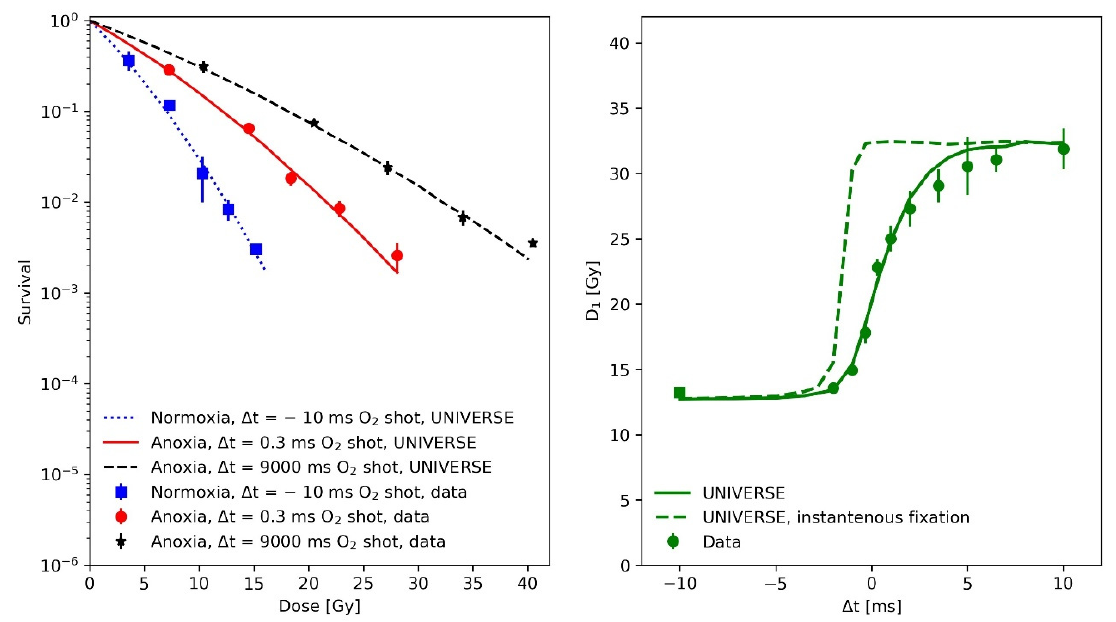
Figure 1. ( Left panel ): Measured (filled circles) and predicted (lines) V79 379A cell survival after a 5 ns electron pulse under various conditions and of O 2 contact times: squares and dotted line, normoxic condition with O 2 -shot contact 10 ms before electron pulse; stars and dashed line, anoxic condition with O 2 -shot contact 9000 ms after electron pulse; and circles and solid line, anoxic condition with O 2 -shot contact 0.3 ms after electron pulse. ( Right panel ): dose of a 5 ns electron pulse required to achieve a constant 1% survival (D 1 ) as a function of O 2 -shot contact time: square, normoxic condition data with O 2 -shot contact 10 ms before electron pulse; and circles, anoxic condition data with O 2 -shot contact at variable time. Positive and negative Δ t represent O 2 -shot contact at the times indicate after or before irradiation. ∆ t = 0 represents simultaneous irradiation and O 2 –shot contact. The solid line depicts model predictions including the oxygen-dependent fixation of damages with a half-life of 1 ms, while the dashed line shows the effect of an assumed instantons damage fixation (half-life = 0 ms). Data taken from